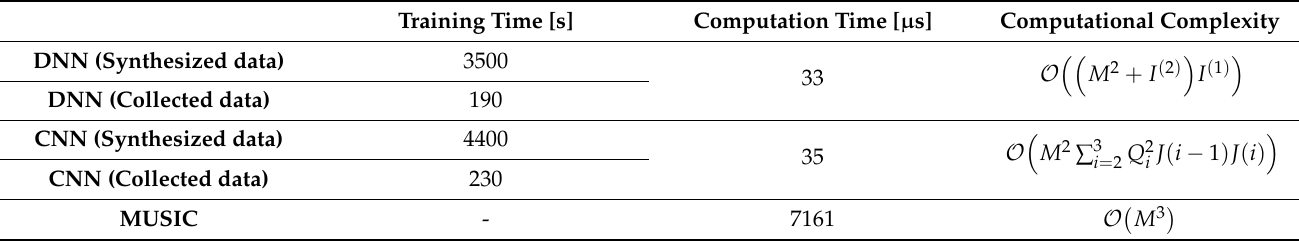
Table 4. Analysis on training time, computation time, and computational